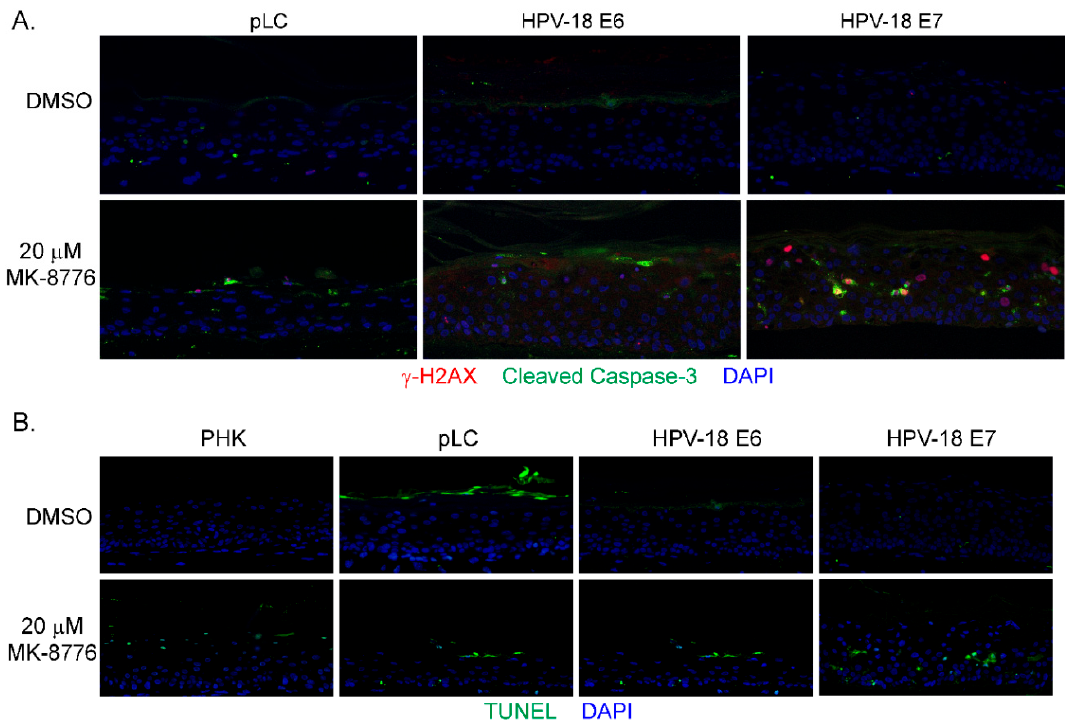
Figure 6. HPV-18 E7 sensitizes PHK raft cultures to Chk1 inhibitor MK-8776. ( A ) Detection of biomarkers of DNA damage ( γ -H2AX, red) and apoptosis (cleaved caspase 3, green) by dual IF in raft culture sections. ( B ) Apoptosis was detected by TUNEL assay on sections from raft cultures of uninfected PHK (PHK), PHK containing empty vector (pLC), HPV-18 E6 or E7. Images were captured with 20 × objective. Only E7-expressing culture exhibited signals in the spinous strata. The Most signals in the other three cultures were observed in stratum corneum.